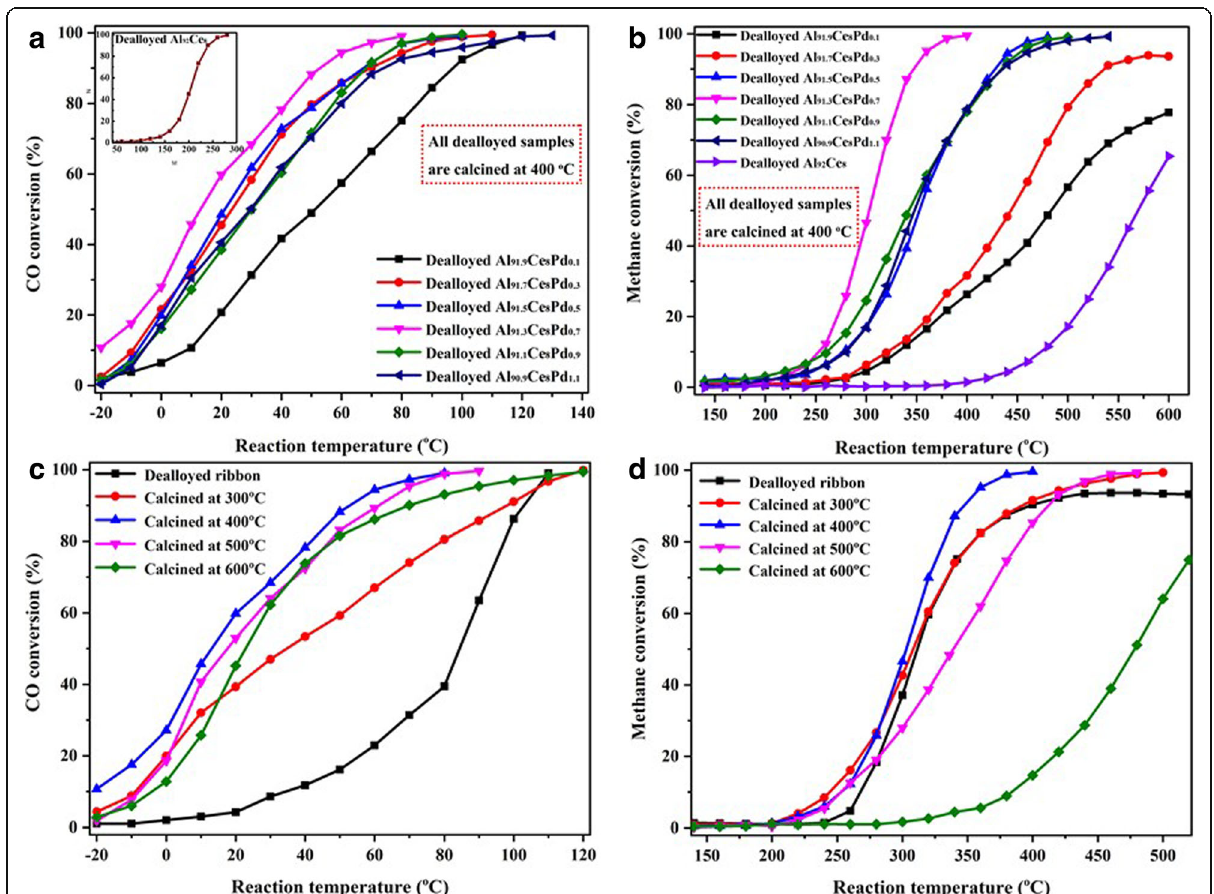
Fig. 8 CO conversion ( a ) and CH 4 conversion ( b ) as functions of the reaction temperature on the dealloyed Al 90 Ce 10 ribbons and the dealloyed Al-Ce-Pd ribbons with different Pd contents calcined at 400 °C. The CO conversion ( c ) and CH 4 conversion ( d ) as functions of the reaction temperature on the dealloyed Al 91.3 Ce 8 Pd 0.7 calcined at different